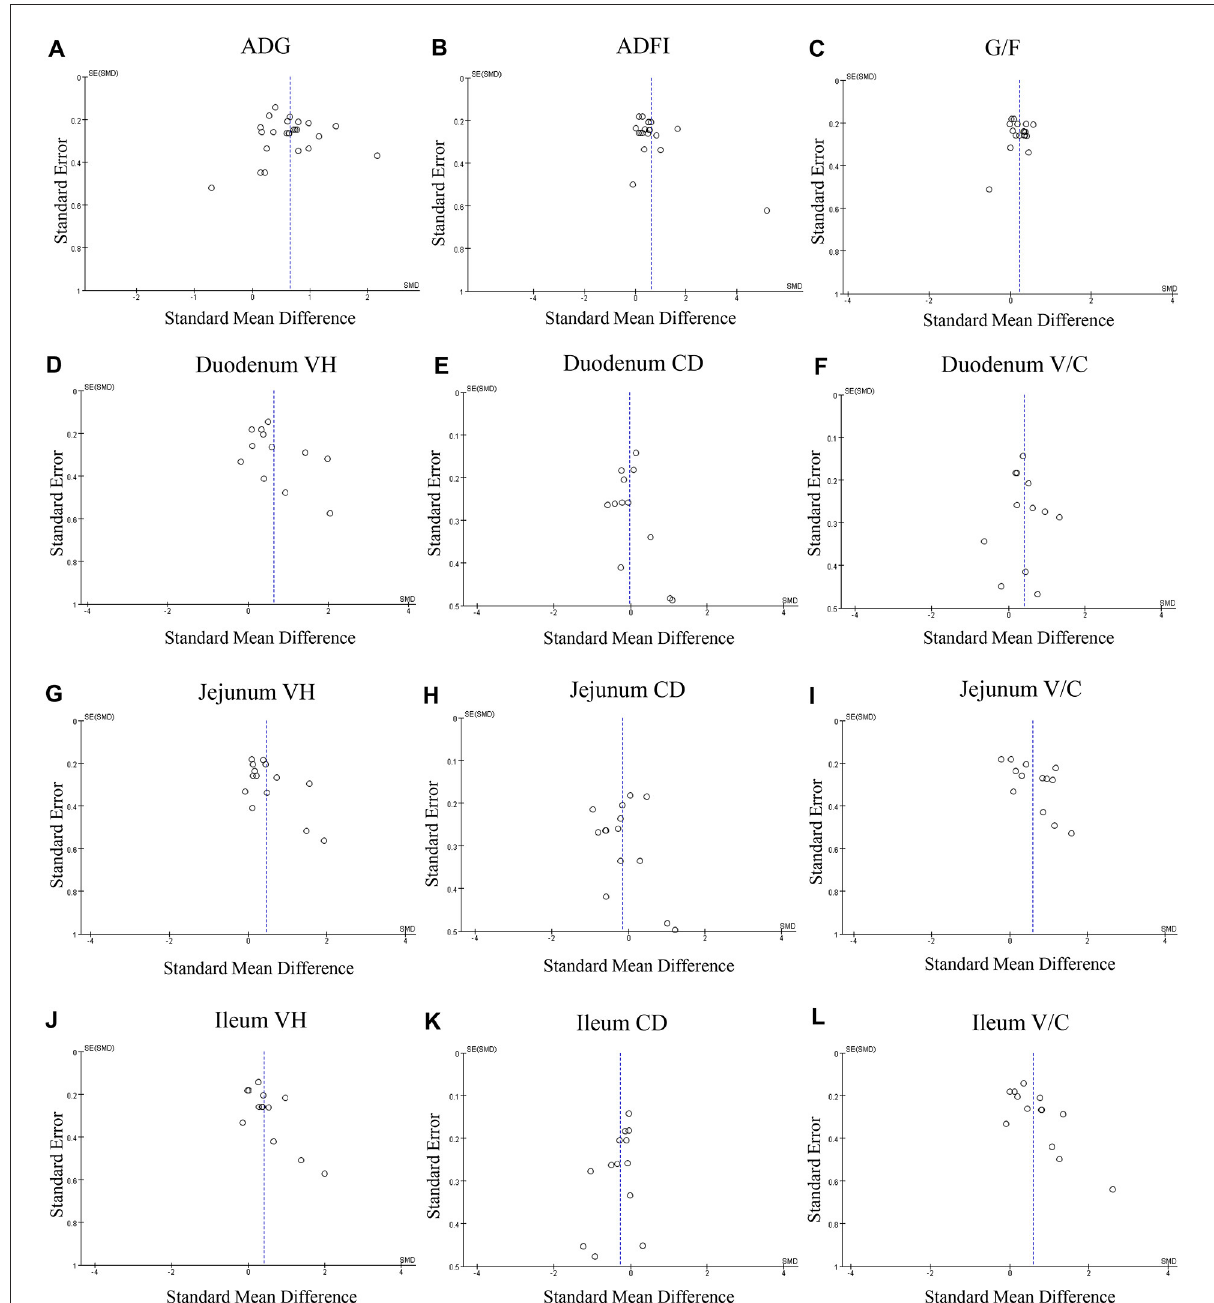
FIGURE3 Funnel plots of the publication bias analysis of included outcomes on pigs. (A) Average daily gain, (B) Average daily feed intake. (C) Gain: feed ratio. (D) Duodenal VH. (E) Duodenal CD. (F) duodenal V/C. (G) Jejunal VH. (H) Jejunal CD. (I) Jejunal. (J) Ileal VH. (K) Ileal CD. (L) Ileal V/C. n = 12; CD, crypt depth; SE, standard error; SMD, standard mean difference; V/C, villus height: crypt depth; VH, villus height; V/C, villus height: crypt depth.